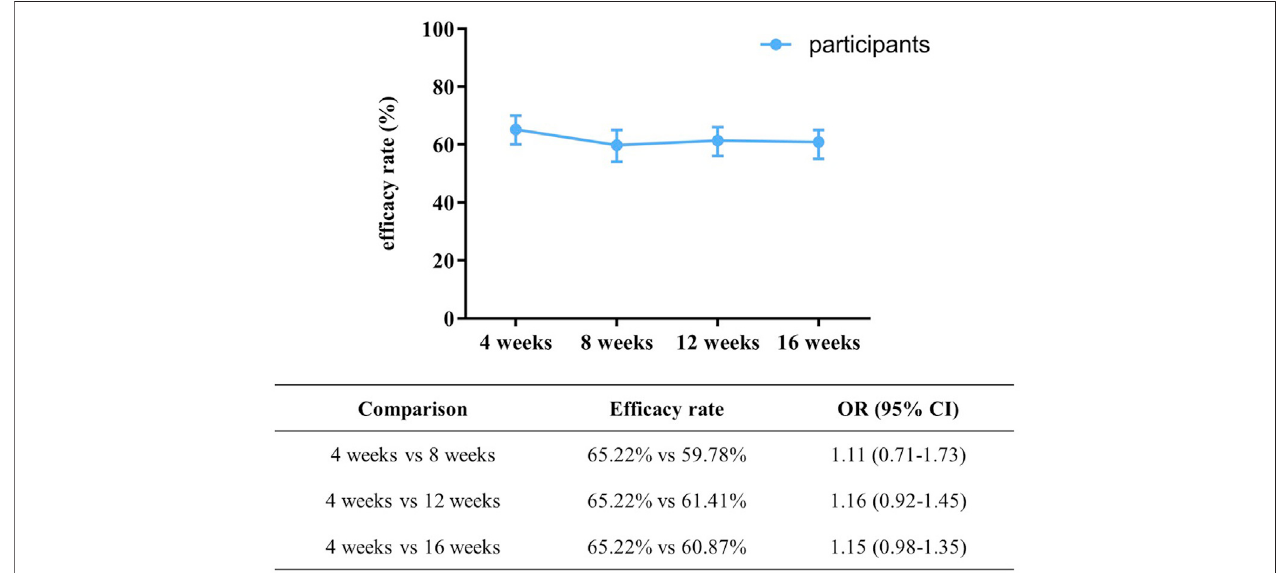
FIGURE 4 | The proportion of participants with favorable treatment outcome at different time points. OR was adjusted for gender, age, education, marital status, BMI, cigarette smoking, types of symptomatic bradyarrhythmia, comorbidity, duration of symptomatic bradyarrhythmia, drug combination, ST-segment changes, completed at least 8-week treatment, and syncope in the past month before